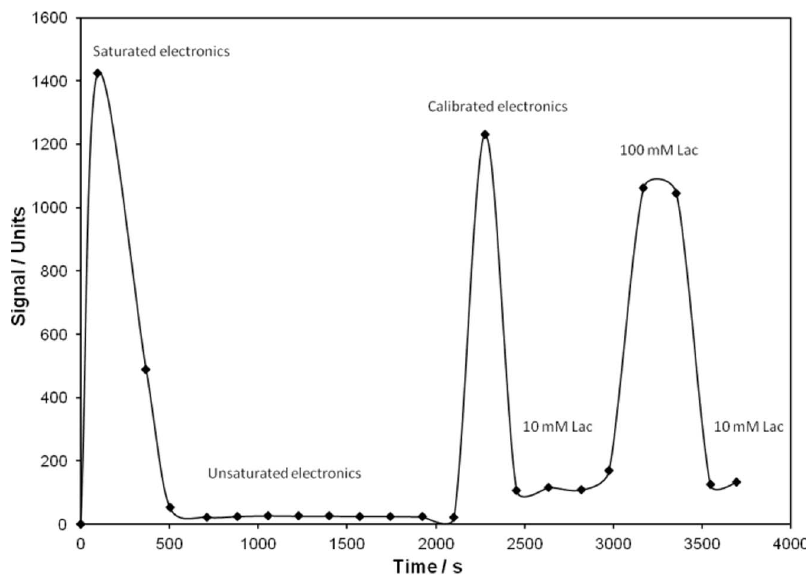
Figure 3. Wireless carbohydrate sensing. Recorded signal from the carbohydrate sensitive self-contained biodevice in buffers with varying lactose concentrations.